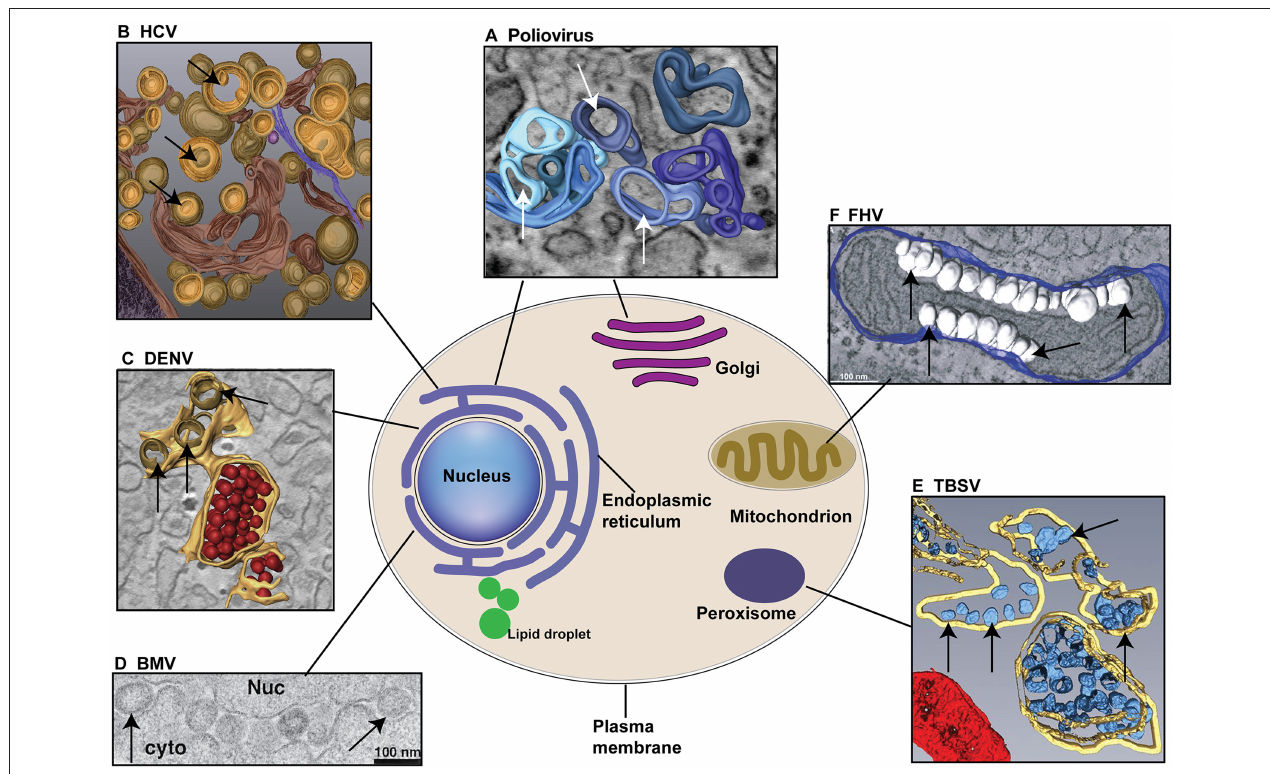
FIGURE 2 | Different ( + )RNA viruses explore specific cellular organelle membranes for VRCs assembly and genome replication. (A) Both ER and Golgi membranes are used for the formation of Poliovirus VRCs. The 3D model indicates the single-membrane tubules formed at early stage of poliovirus infection. (B) HCV utilizes ER membranes to form double-membrane vesicles (DMVs) as VRCs. (C) DENV replicates in association with ER membranes. ER membranes are in yellow, VRCs are in light brown. Note virions (in red) are produced near VRCs. (D) BMV invaginates the outer perinuclear ER membrane to assemble VRCs. Nuc: nucleus; cyto: cytoplasm. (E) TBSV replicates in association with the peroxisomal membranes and VRCs (blue) are formed inside multivesicular bodies (MVB, yellow membranes). (F) FHV invaginates the outer mitochondiral membranes (blue) to build VRCs (White). Arrows point to VRCs. (A–F) are reproduced with permission from Belov et al. (2012) in (A) ; Romero-Brey et al. (2012) in (B) ; Welsch et al. (2009) in (C) ; Schwartz et al. (2002) in (D) ; Fernandez de Castro et al. (2017) in (E) ; and Kopek et al. (2007) in (F)